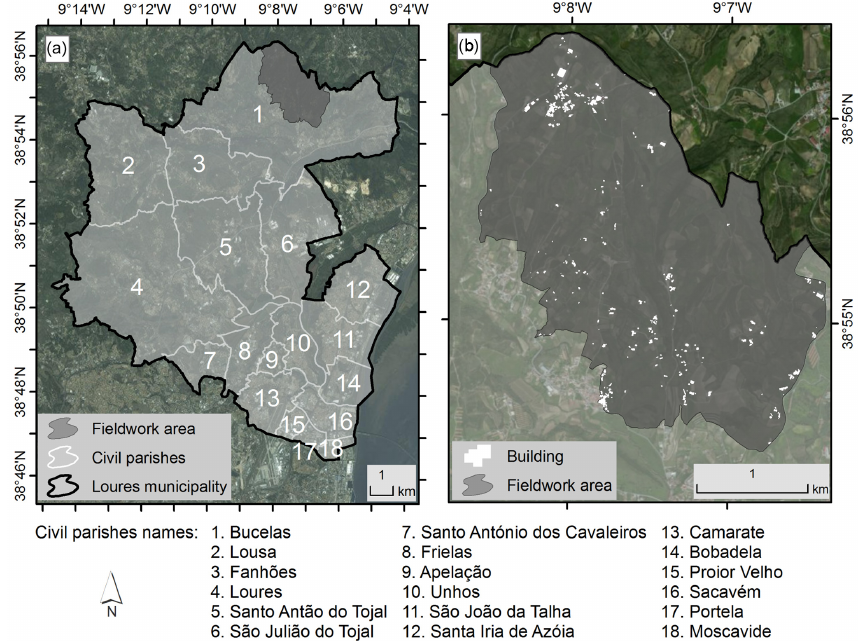
Figure 3. (a) Civil parishes of the Loures municipality and location of the fieldwork area; (b) buildings of the fieldwork